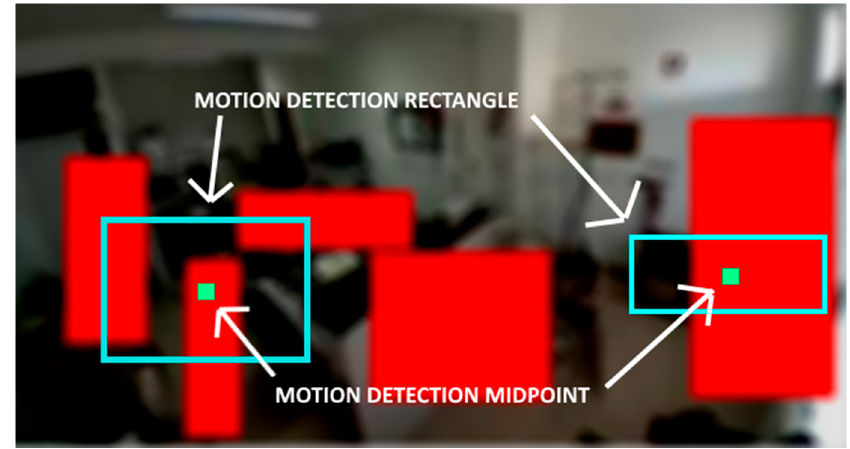
Figure 18. Movement detection optimization.